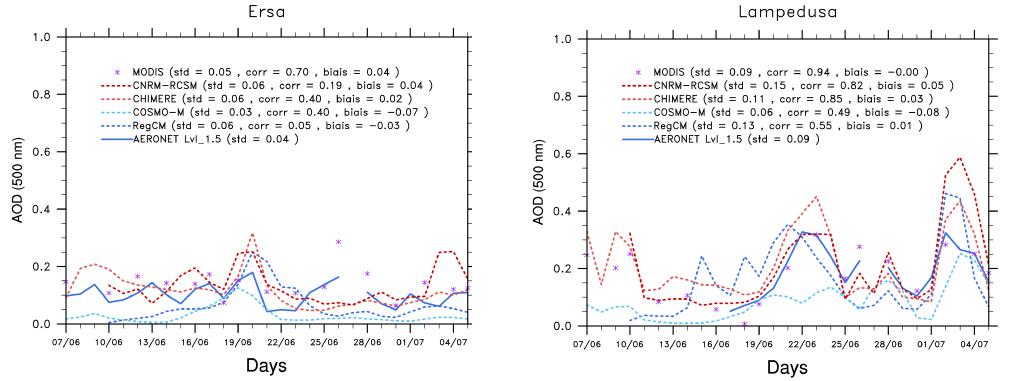
Figure 31. Time series of AOD comparisons between AERONET/PHOTONS observations and COSMO-MUSCAT, CHIMERE, CNRM- RCSM and RegCM model outputs over the two stations of Ersa and Lampedusa. The MODIS retrievals are also